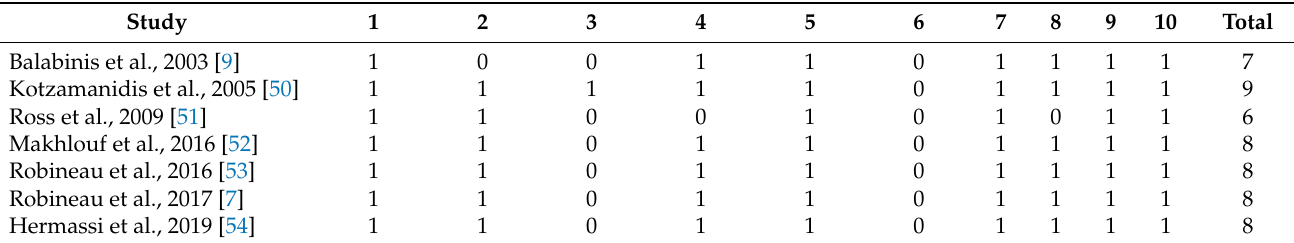
Table 2. Methodological quality assessment for inclusion in the